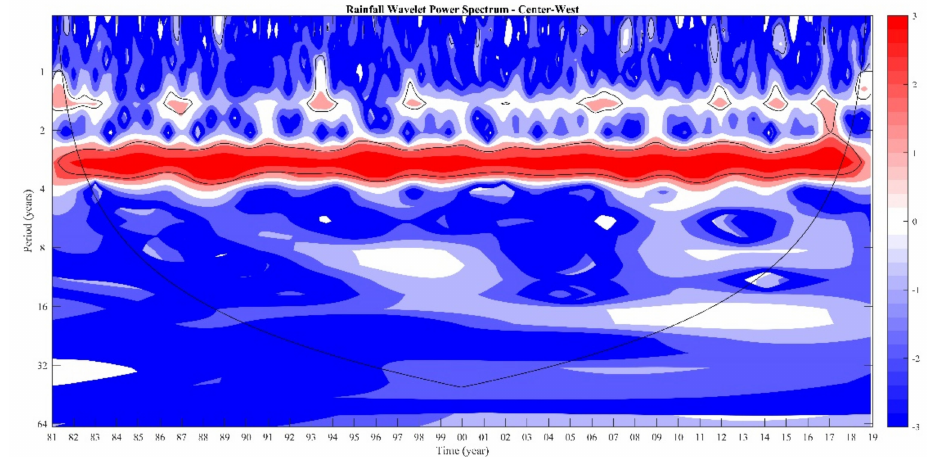
Figure A1. Wavelets (Morlet) analysis